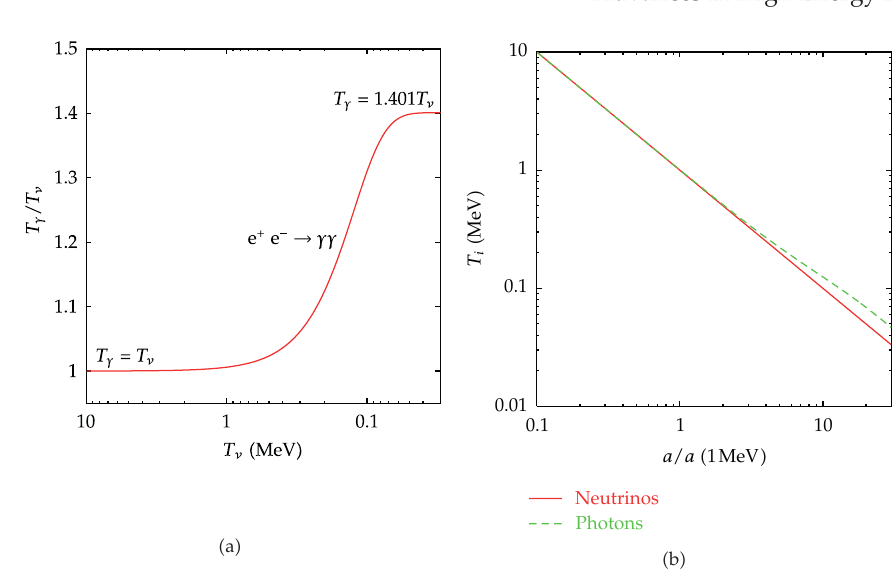
Figure 1: Photon and neutrino temperatures during the process of e ± annihilations: evolution of their ratio (cid:2) a (cid:3) and their decrease with the expansion of the universe (cid:2) b (cid:3) .